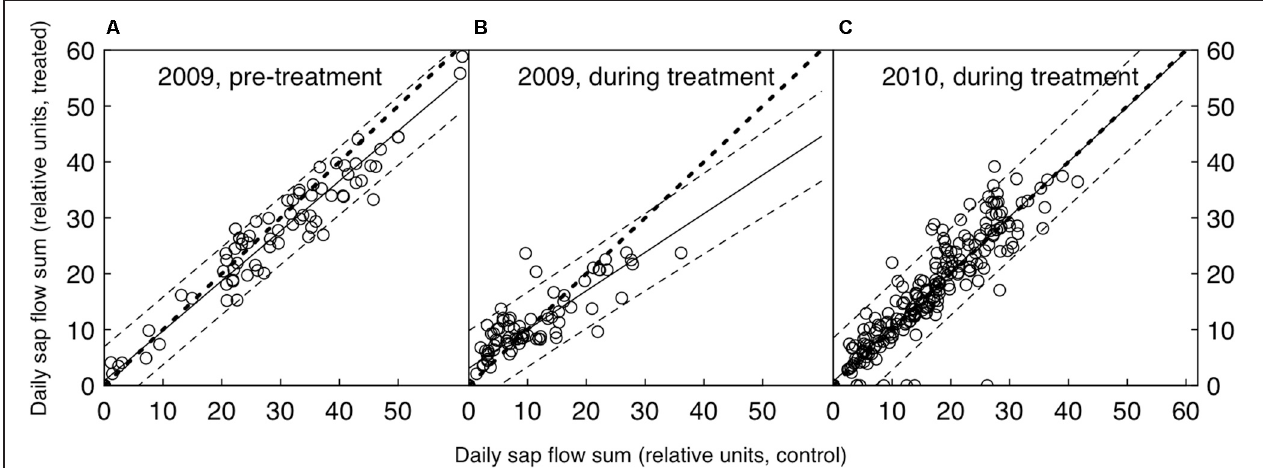
as 95% confidence intervals). The 1:1 line lies within the confidence intervals where data points are available, suggesting that there was no significant difference between treated and control trees in any of the three periods